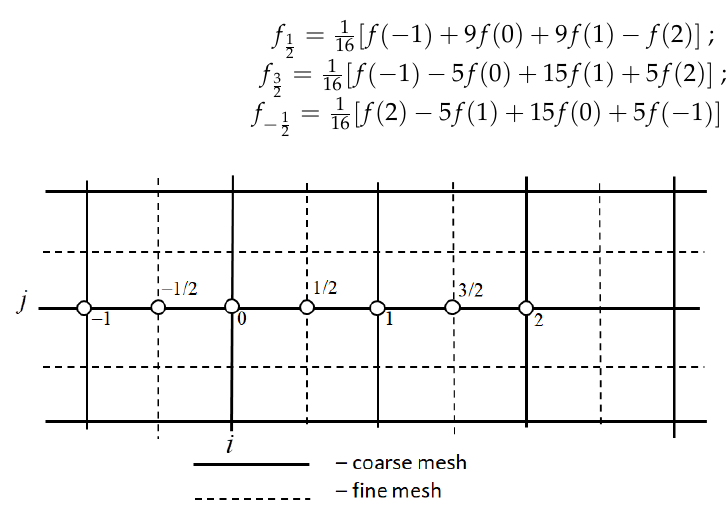
Figure 4. Node numbering when transferring grid functions from the coarse grid to the fine one. When switching from the coarse to the fine grid, the values of the function at coinciding nodal points (points with integer numbers in Figure 4) are preserved. At points belonging only to a fine grid (points with fractional numbers in Figure 4), the values of the functions are recalculated first in the direction of axis ϕ , and then z . At points adjacent to the boundaries of the integration region, formulas for f − 1/2 and f 3/2 are applied, and at other points—for f 1/2